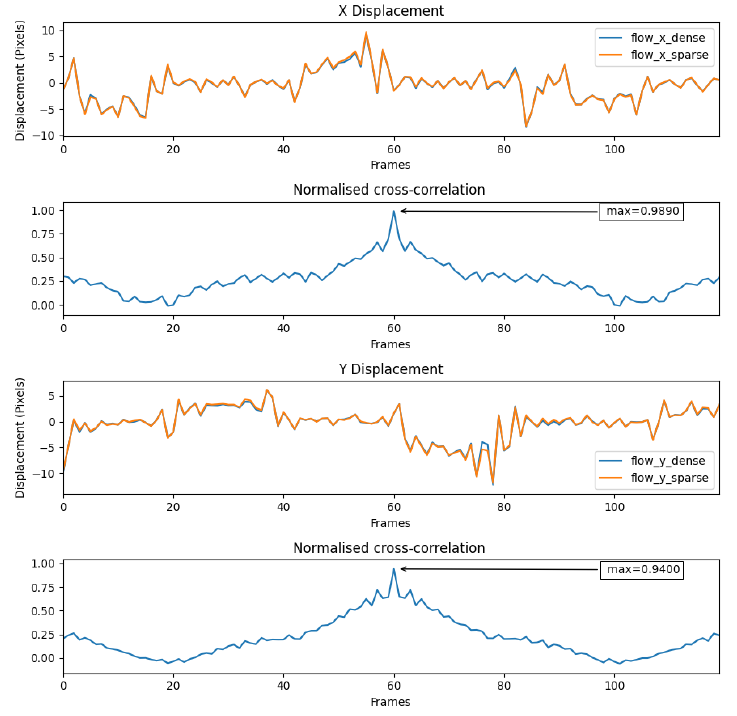
Figure 16. Dense and sparse technique signals on dataset 2 during high thermal